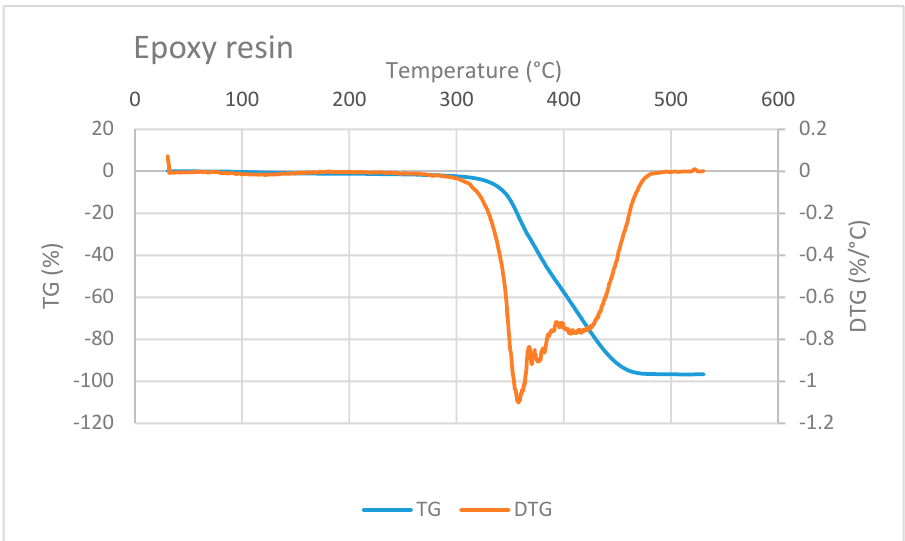
Figure 7. TG/DTG curve of epoxy resin showing decreasing mass at temperature higher than 300 °C.